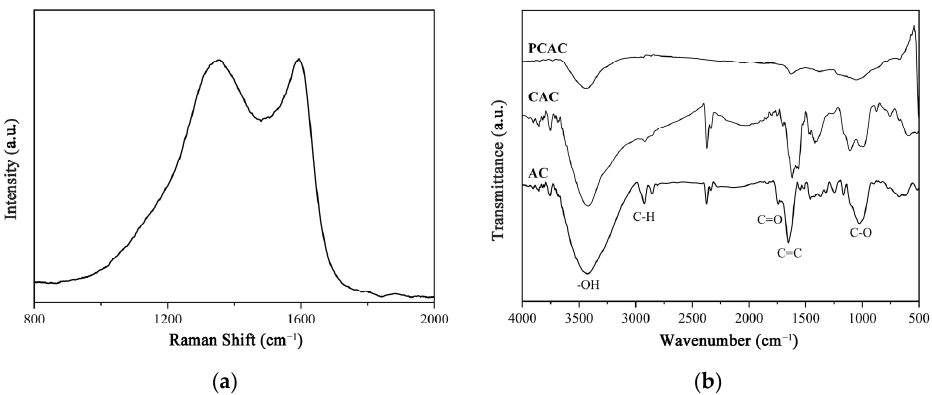
Figure 4. ( a ) Raman pattern of PCAC; ( b ) IR spectra of biomass, biochar, and porous carbon. The samples of biomass, biochar, and porous carbon were characterized by IR (Figure 4b). In the IR spectrum of AC, the peaks at 3423, 2927, 1743, 1634, and 1029 cm − 1 may be attributed to the -OH, C-H, C=O, C=C, and C-O stretching vibrations, respectively. This indicates that the components of AC are similar to other biomasses, which are mainly composed of lignin, hemicellulose, and cellulose [41,42]. The IR spectrum of CAC is sim-